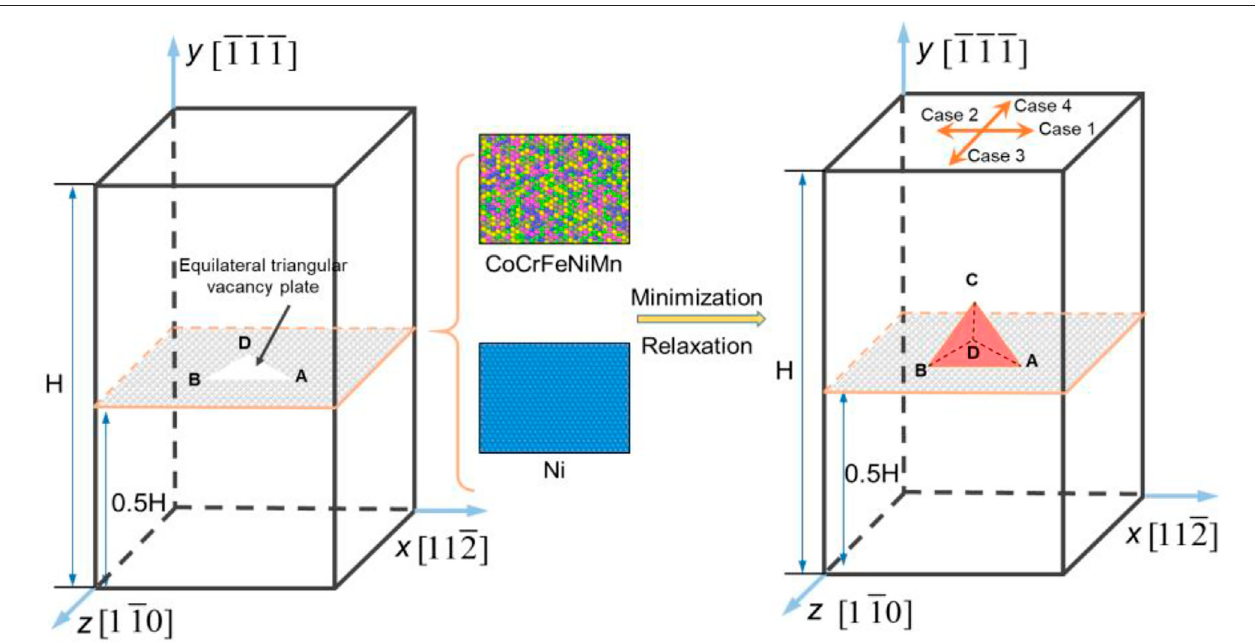
FIGURE 1 | Schematic illustration of the simulation process. Case 1 to Case 4 indicate that the shear directions are ( 111 )[ 112 ] , ( 111 )[ 112 ] , ( 111 )[ 110 ] , ( 111 )[ 110 ] of the samples, respectively. A, B, C and D are the four vertices of the SFT.